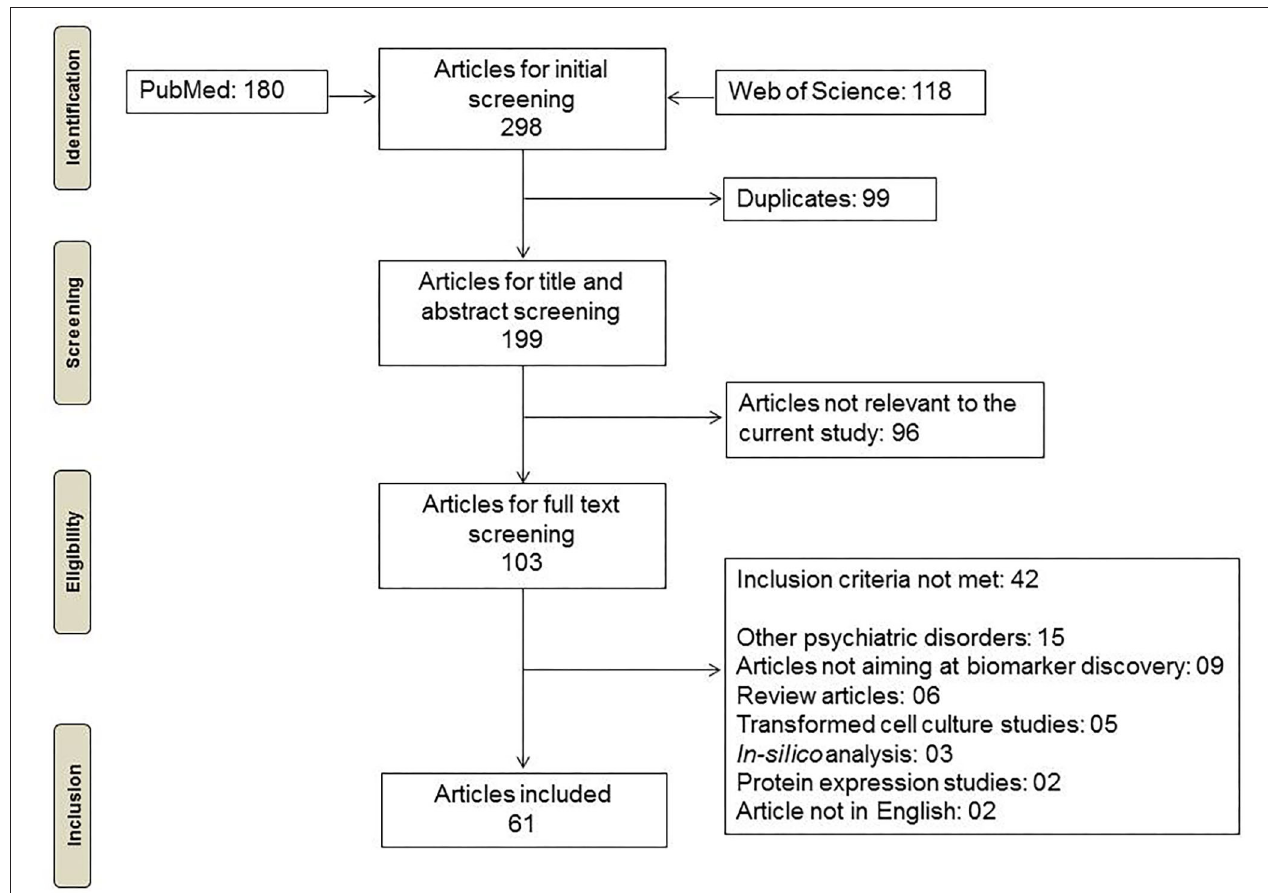
FIGURE 1 | Flowchart depicting the methodology for inclusion of